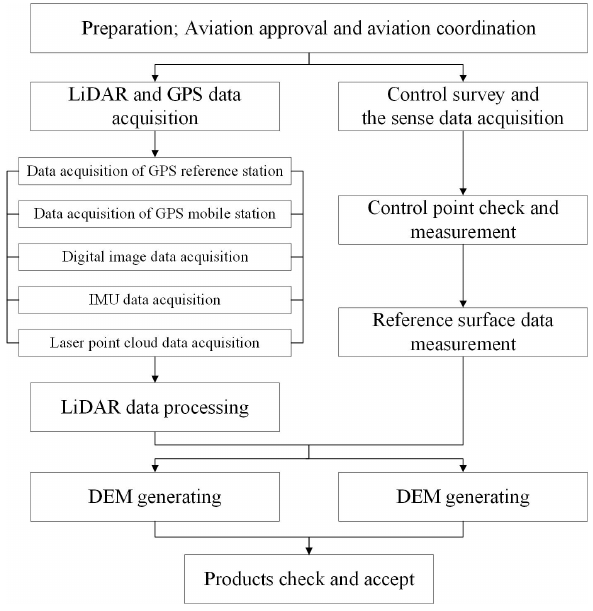
Figure 5. The flow chart LiDAR data